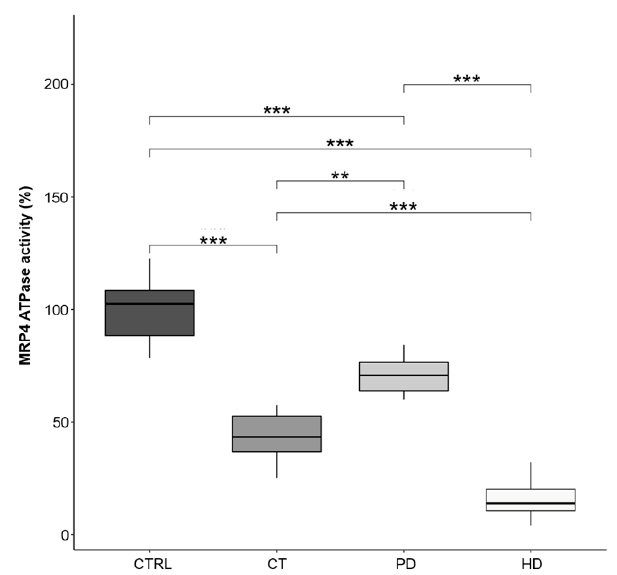
Figure 4. MRP4 ATPase activity in RBCs. ATPase activity was measured spectrophotometrically after immunoprecipitation of MRP4 from membrane fraction of RBCs obtained from all the study population (CTRL, CT, PD, HD; N = 10 for each group). Horizontal black lines in box plots indicate the medians, boxes the interquartile range (IQR) and the bottom and top whiskers represent the minimum and maximum values. (** p < 0.01; *** p < 0.001). Again, by matching the data on MRP4 activity, its nitration/nitrosylation levels (Fig-